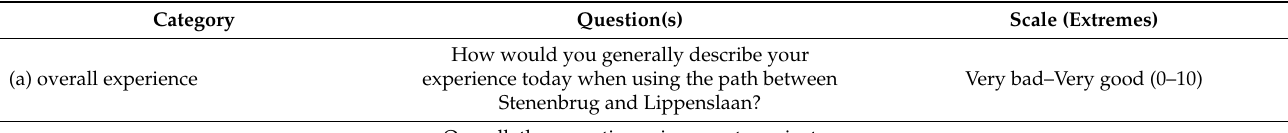
Figure 3. Plan of the case study area with survey points marked by black dots (map adapted from Google Maps); The length of the whole cycling/walking path is approximately 560 m. Table 1. Summary of the on-site questionnaire items used in this study. The order of categories does not reflect the order of presentation to participants, it is adapted for analysis